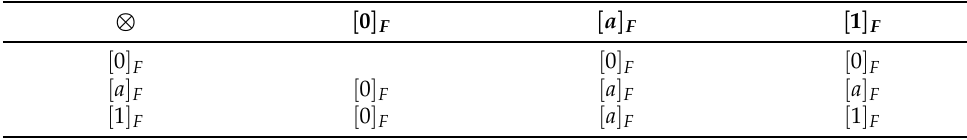
Figure 5. Hasse diagram of lattice L / ∼ F . Table 15. The operation ⊗ on L / ∼ F .